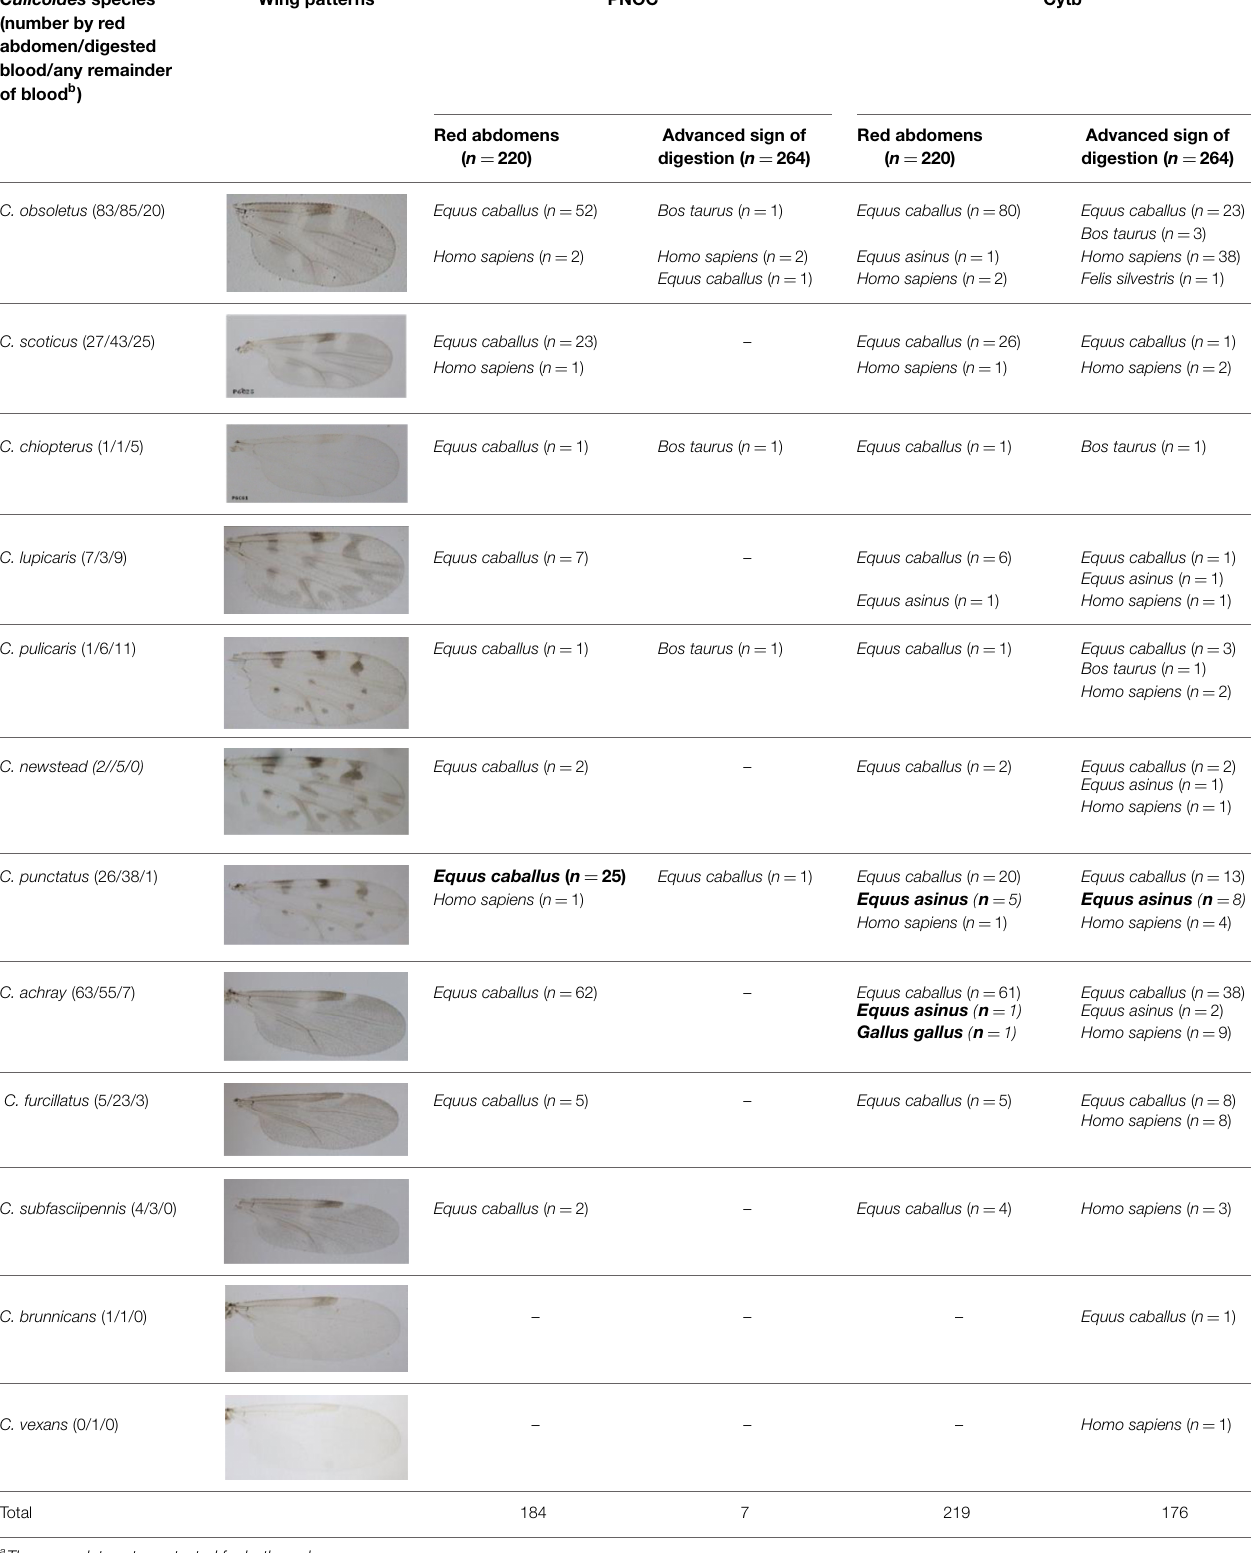
TABLE 3 | Origin of blood meals from blood-fed Culicoides spp . Culicoides species a (number by red abdomen/digested blood/any remainder of blood b